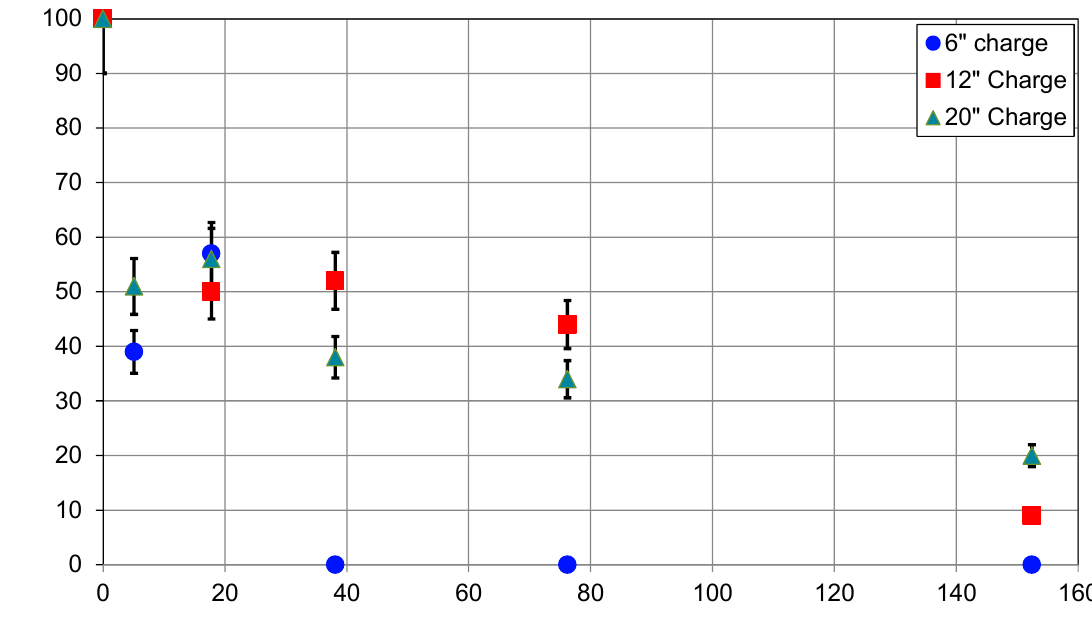
Figure 8. Fraction of unreacted aluminum from deposit on coupons inserted into a propellant plume.